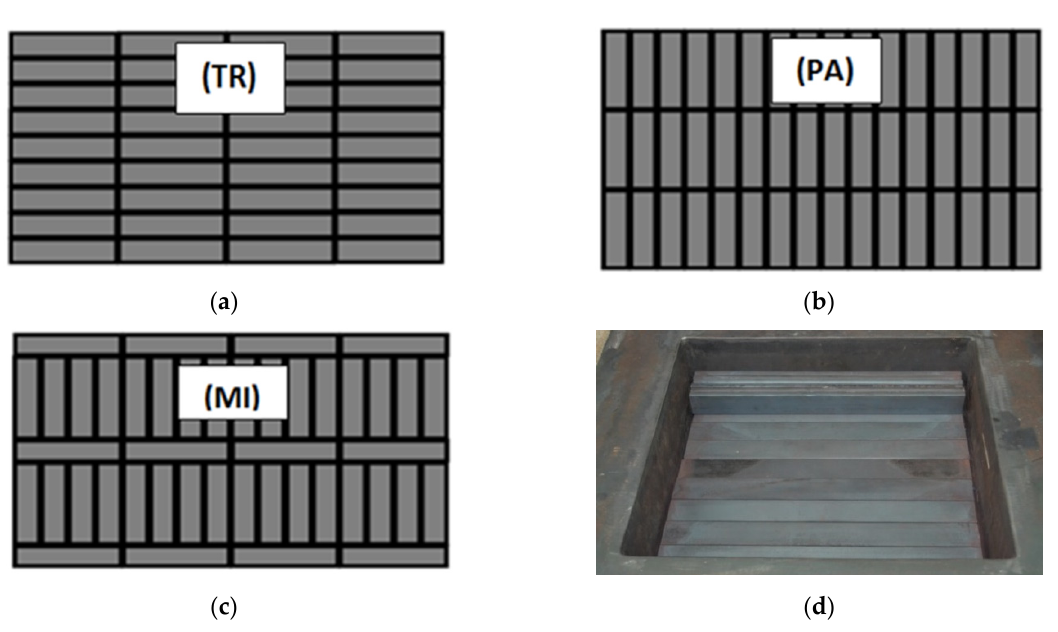
Figure 3. Investigated samples: ( a ) transverse sample; ( b ) parallel sample, ( c ) mixed sample; ( d ) one of the samples during placing in the heating chamber of the stand.